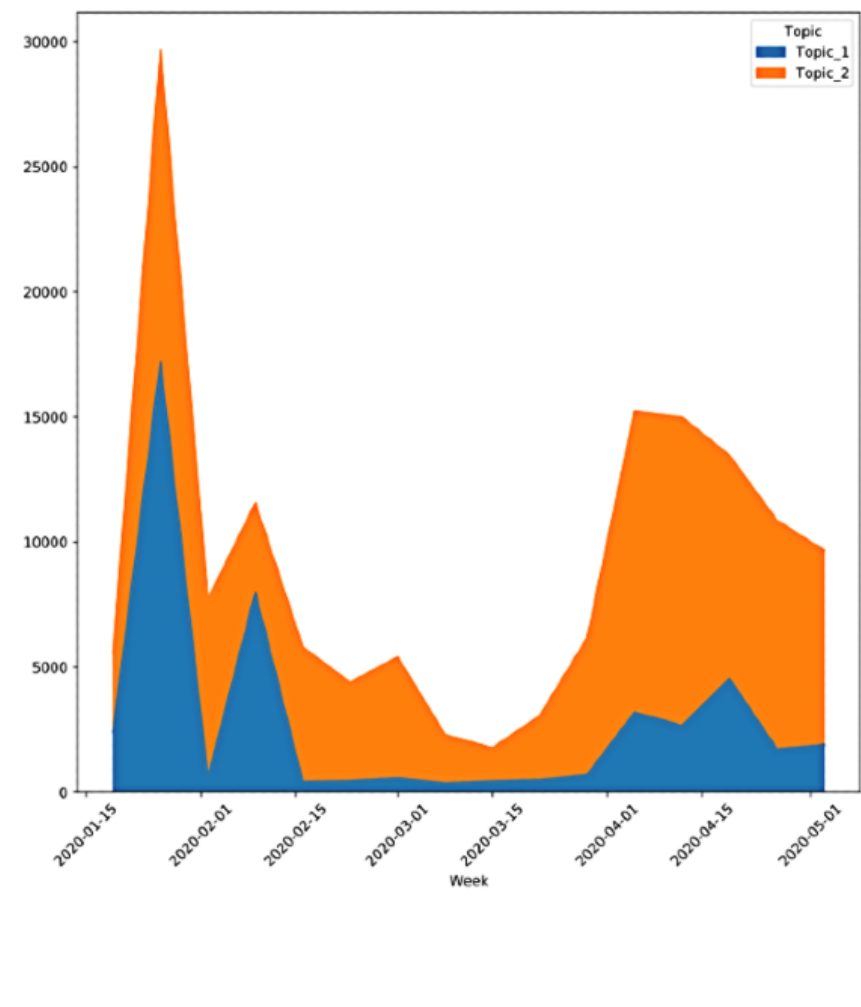
Figure 6. Topic distribution over time for the 2-topic dynamic topic model for tweets related to the conspiracy topic of Bill Gates and the Bill & Melinda Gates Foundation. Tweets belonging to Topic 1 are more common in the conversation in January, while Topic 2 becomes more prominent in the spring. Additionally, distinct peaks show the popularity of tweets related to this conspiracy theory category